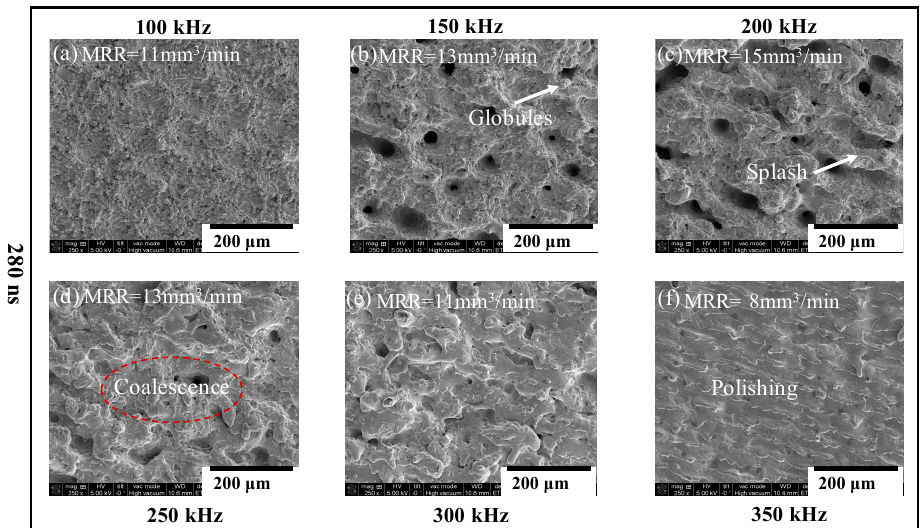
Figure 12. SEM micrographs of the surface topology at di ff erent PRFs processed at ED A of 4.2 J / mm 2 at 280 ns.